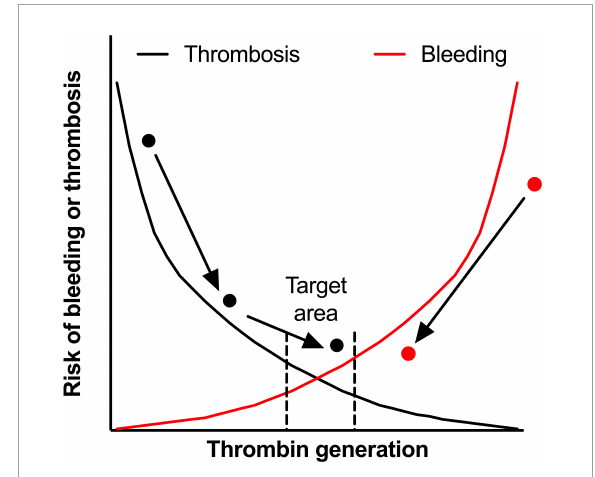
FIGURE2 The hemostatic balance. The hemostatic balance is depicted as the risk of thrombosis (black line) and the risk of bleeding (red line), which is dependent on thrombin generation (on the x-axis). In the target area, both the risk of thrombosis and the risk of bleeding are acceptably low, but can still occur in an individual patient in certain circumstances. Two patients are shown in the figure, the black dot represents a patient with a venous thrombo-embolism during an hypercoagulable state. With treatment the hypercoagulable state is diminished, but the patient experiences a second thrombotic event while on adequate anticoagulant therapy. By intensifying anticoagulant treatment, this patient reaches the target area. On the other side of the curve, the red dot represents an hemophilia A patient with a high bleeding rate. After starting prophylactic therapy with factor VIII concentrate, the bleeding phenotype improves, but doesn’t reach the target area. However, for this patient the reduction in bleeding is acceptable, while intensifying treatment could lead to overshoot to a risk of thrombosis. In both patients, monitoring with TGAs could identify the target area better. This could have prevented the second thrombosis in the patient represented by the black dot as the hypercoagulable state was recognized